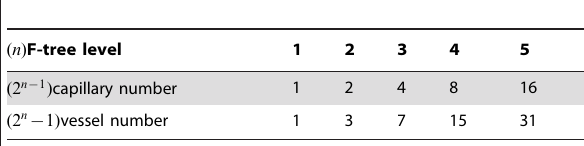
Table 4. Vessel numbers and capillary numbers of